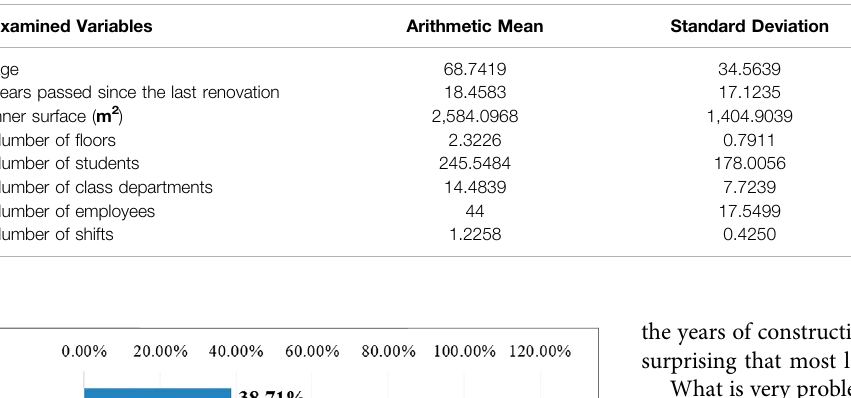
TABLE 2 | Descriptive statistics of general data on schools.